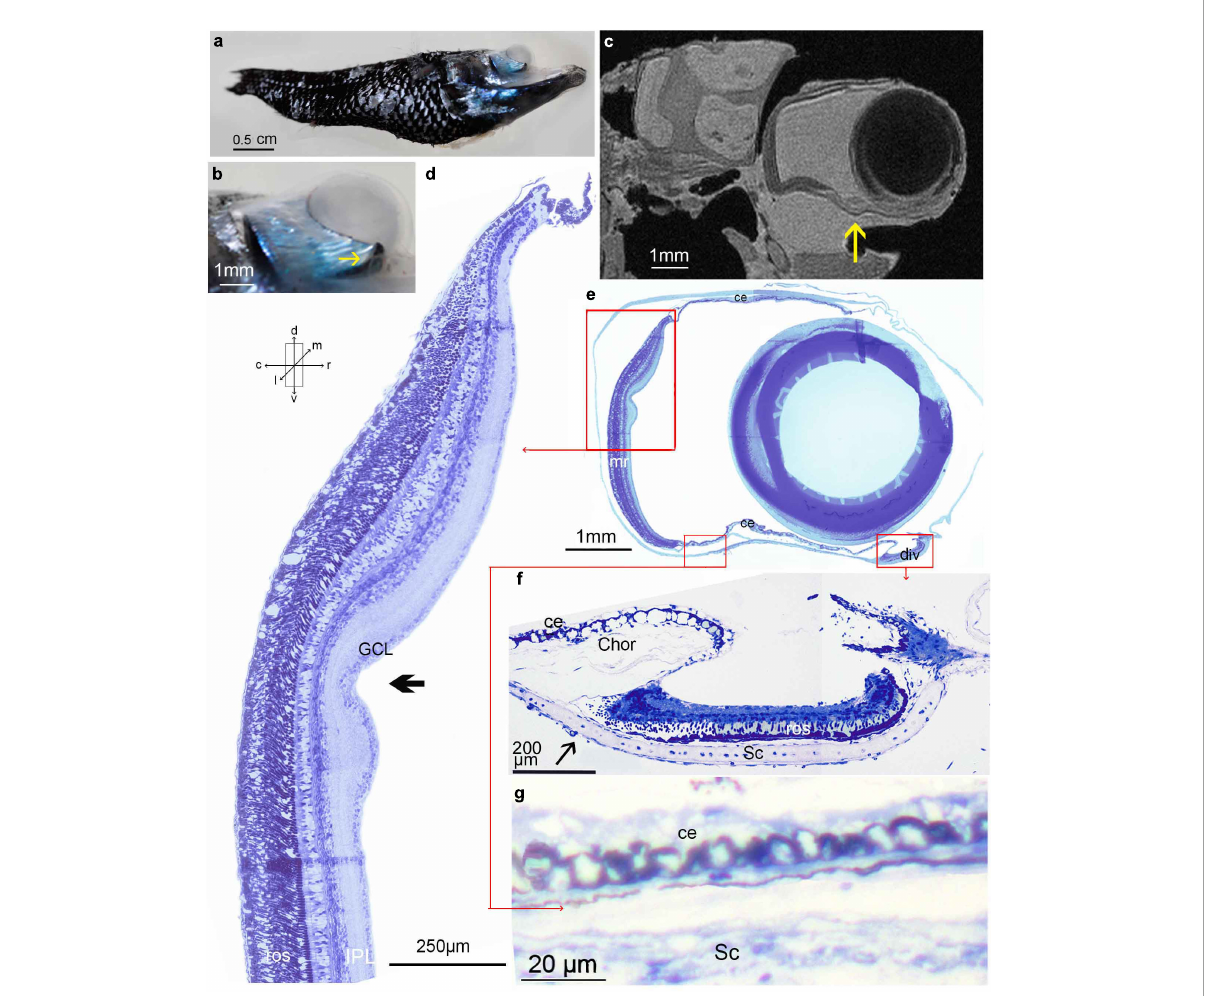
FIGURE2 Winteria telescopa : (a) side view of entire animal (SL 42 mm); (b) higher power view of the right eye, arrow indicates diverticulum; (c) MRI scan in the sagittal plane, arrow indicates diverticulum; (d) radial semithin section of the main retina, arrow indicates a marked depression in the retina, located approximately 1.1 mm from the dorsal rim; (e) semithin, approximately sagittal, section of the tube eye with lens probably artifactually displaced caudally; (f) radial semithin approximately sagittal section of the diverticulum. Note the thinning of the RPE caudally indicated by an arrow, which represents the transparent ‘window’; (g) non-photosensitive ciliary epithelium of the ventral wall of the tube eye; a regular accessory retina is present on the medial wall which is not in this plane of sectioning. The orientation arrows shown are applicable to all panels but see Materials and Methods for comments on deviations from the horizontal plane in histological